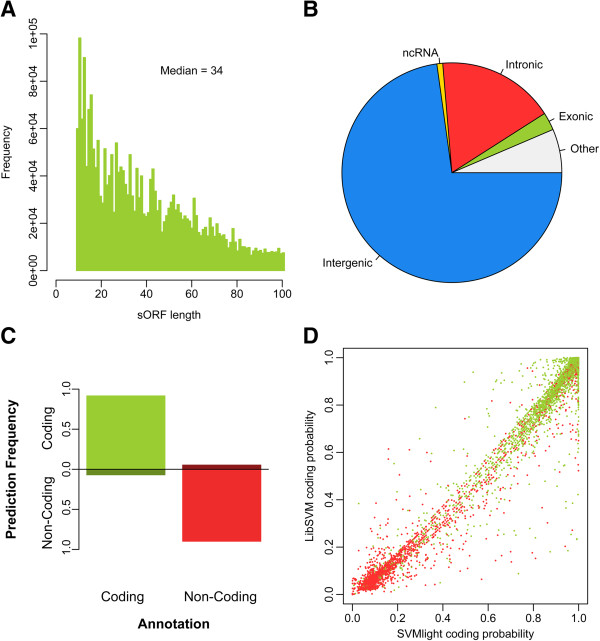
Overview of the in silico coding sORF prediction. (A) Histogram of the total number of sORFs depicted by ORF length (in AA). (B) Distribution of sORFs according to their genomic location. sORfs overlapping more than one different category are grouped as “others”. (C) Evaluation of the sORF coding probability. The fractions of annotated and predicted coding and non-coding sORFs within the test dataset are plotted. (D) Visual representation of the classification of all 9,612 test subjects, based upon both SVMs (SVMlight and libSVM). True coding sORFs are depicted in green and true non-coding in red (see Additional file 1: Figure S2).